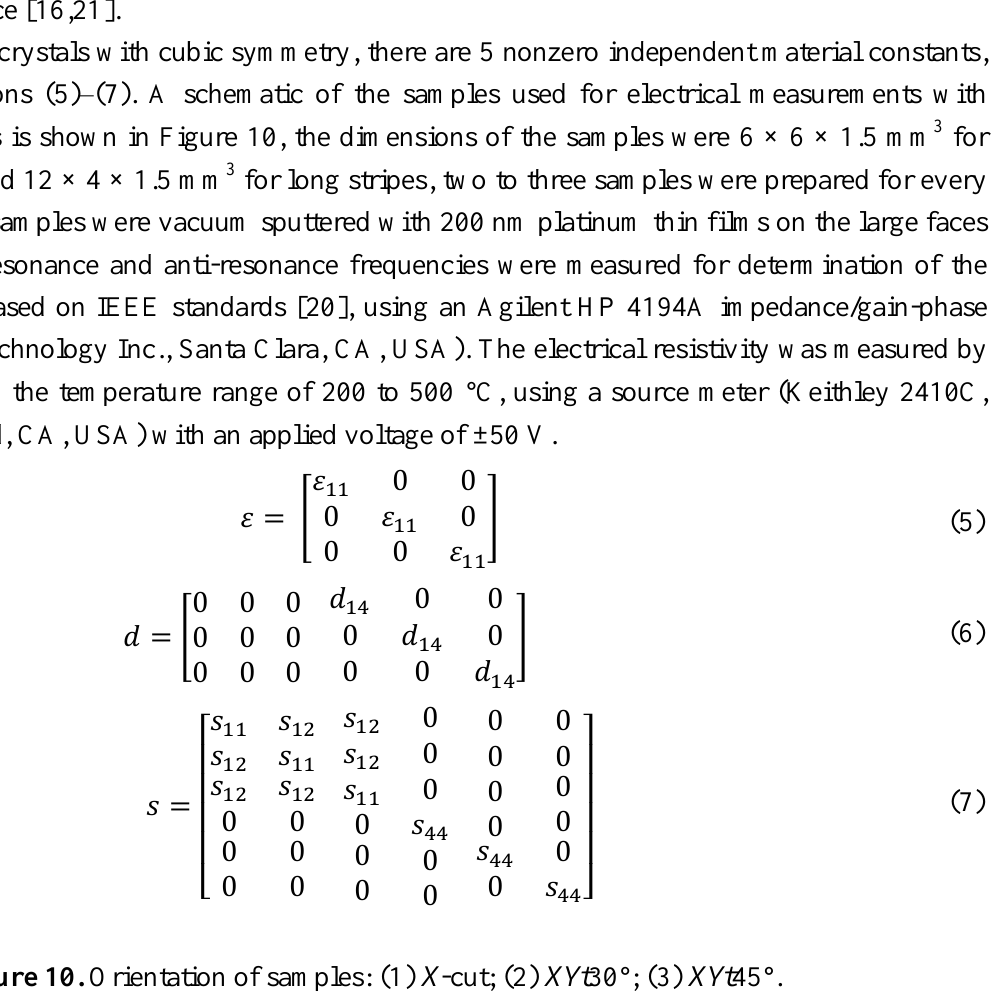
Figure 10. Orientation of samples: (1) X -cut; (2) XYt 30°; (3) XYt